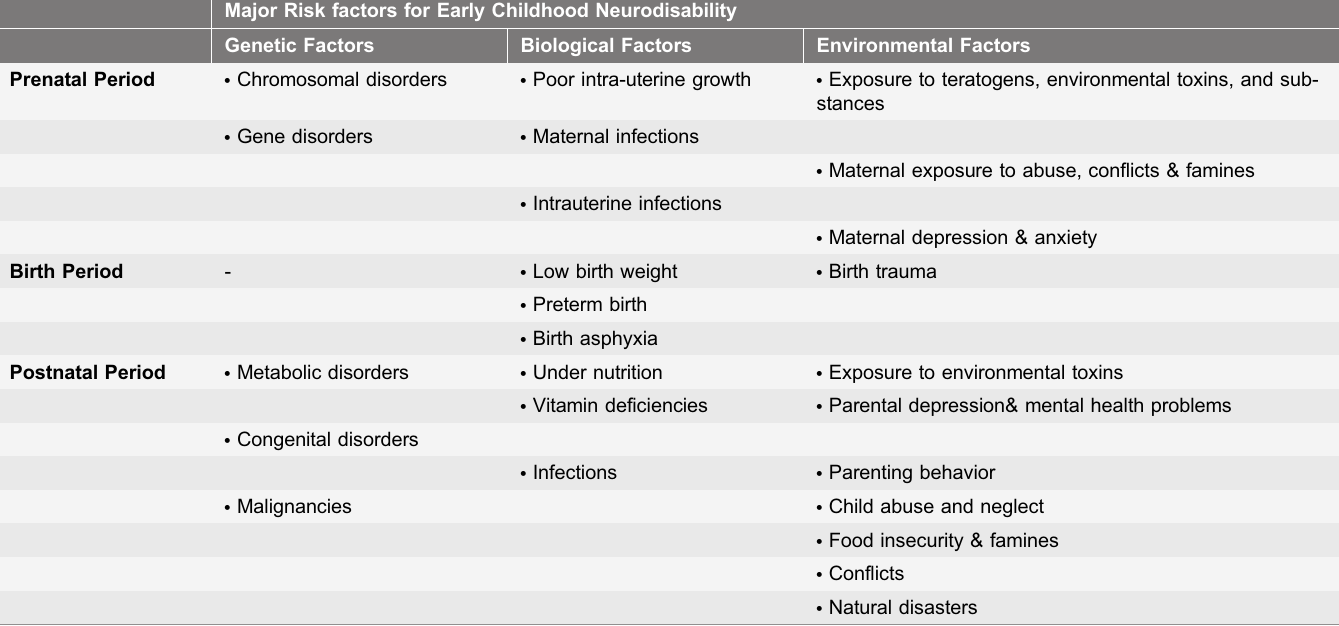
Table 1. Summary of major risk factors for early childhood